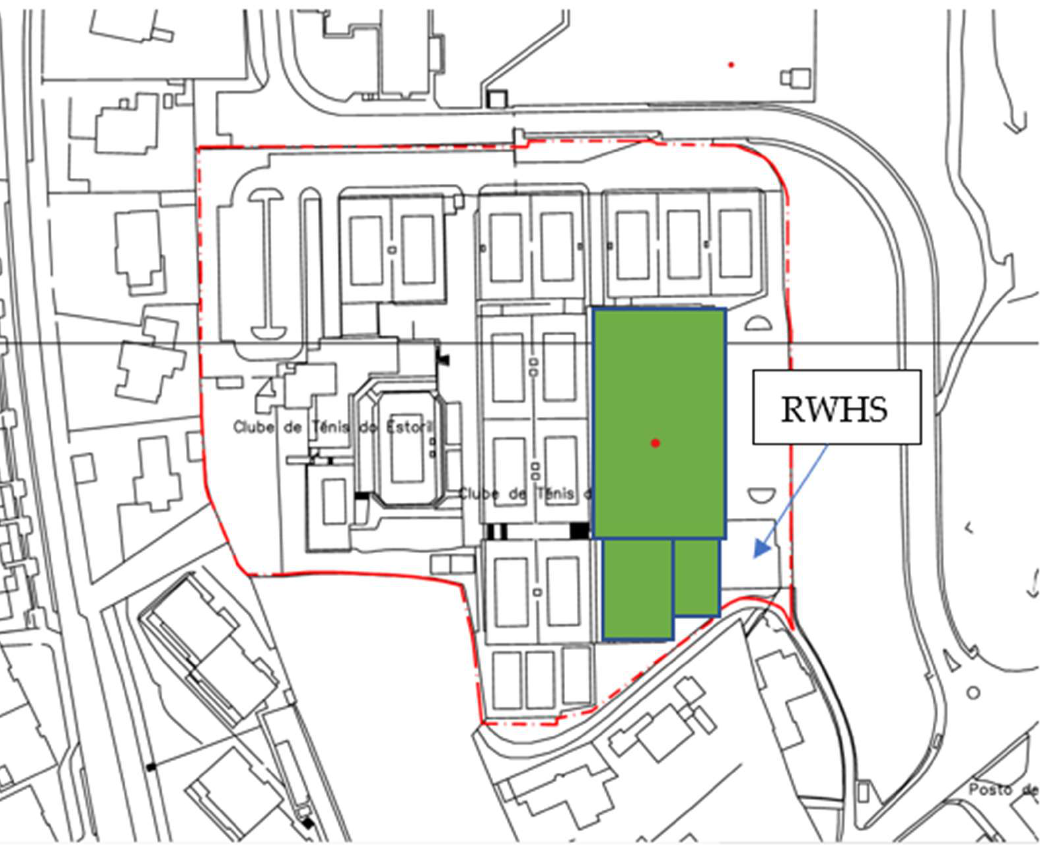
Figure 2. The Estoril Tennis Club (ETC) plan with the location of the rainwater harvesting system (RWHS) covers and installation site.